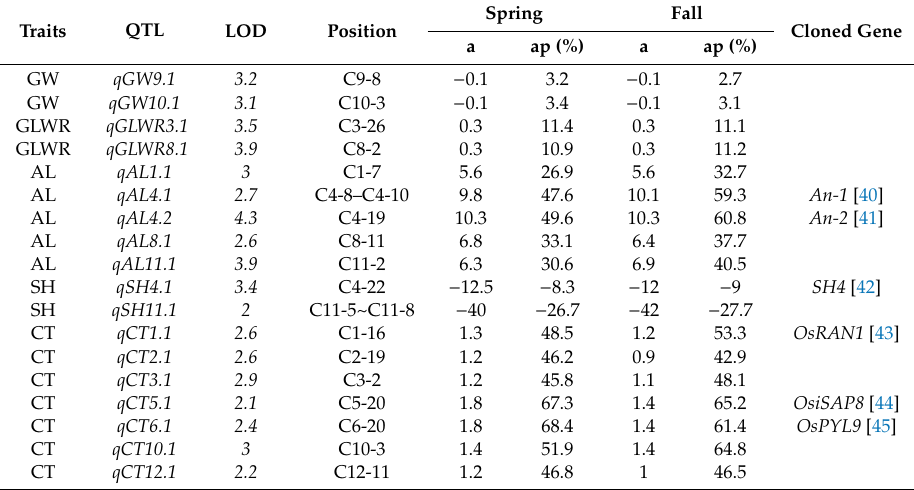
List of wild rice QTLs identified in this study. Position—physical position of molecular markers on chromosomes (Mb); length—length of the overlapping part of the lines; a—additive e ff ect; Gene— cloned genes in the overlapping segments. TA— tiller angle; HD—heading date; PH—plant height; NGPP—number of grains per panicle; GWT—1000 grain weight; GL—grain length; GW—grain width; GLWR—grain length to width ratio; AL—awn length; SH—grain shattering; and CT—cold